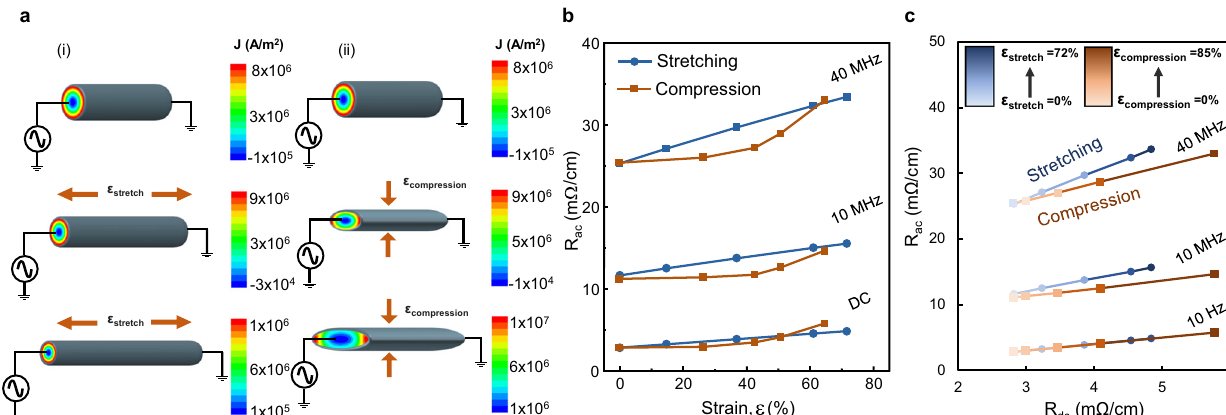
Fig. 2 Simulated AC resistance of liquid metal conductors under stretching and compression. a FEA simulations showing current density for stretching (i) and compression (ii) of a liquid metal sensor at 10 MHz with a 0.5 mm diameter. b Simulated AC resistance per cm for a 0.5 mm diameter as a function of both compressive and stretching strain for 10 Hz, 10 MHz, and 40 MHz. c A mapping of simulated R ac and R dc per cm for increasing degrees of compression and stretching at varied frequencies (10 Hz, 10 MHz, and 40